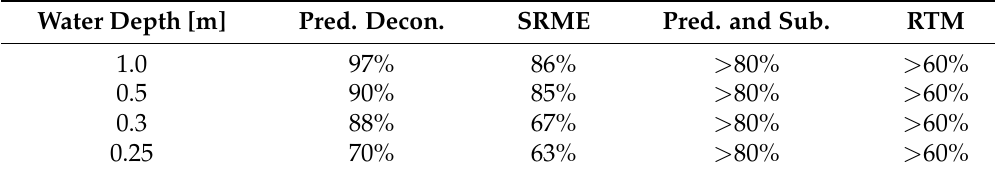
Table 5. Overview of attenuated multiple energy in percent compared to the reflection for each applied method for the synthetic multiple-offset test scenarios.